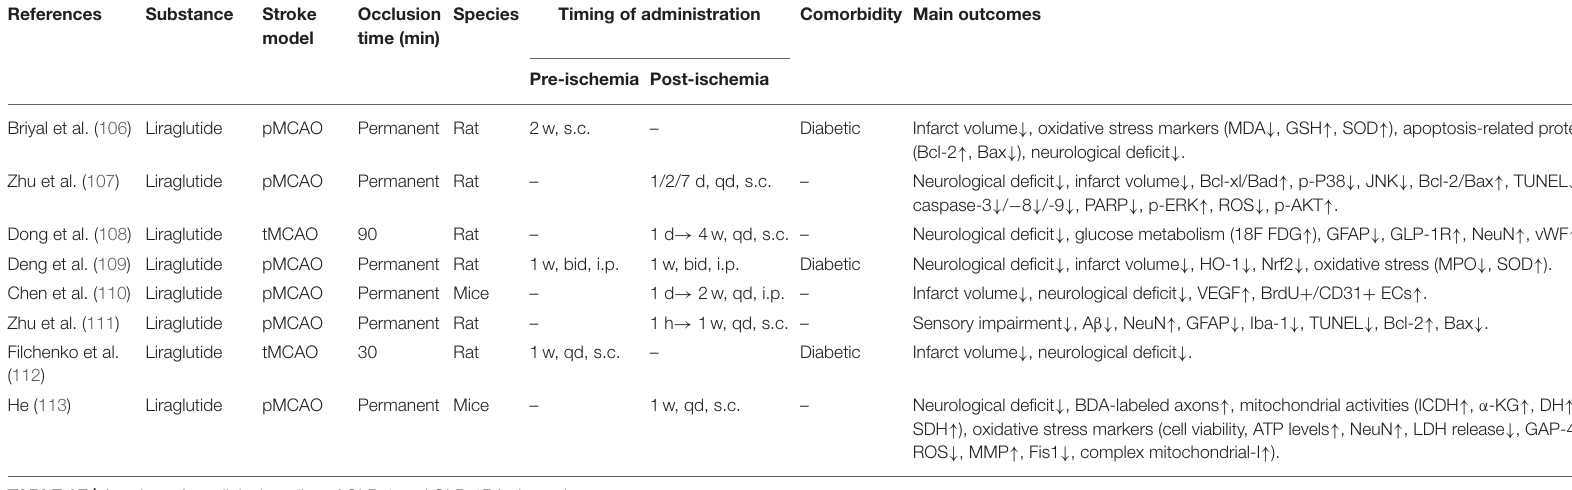
TABLE 2F | A review of preclinical studies of GLP-1 and GLP-1RAs in stroke.